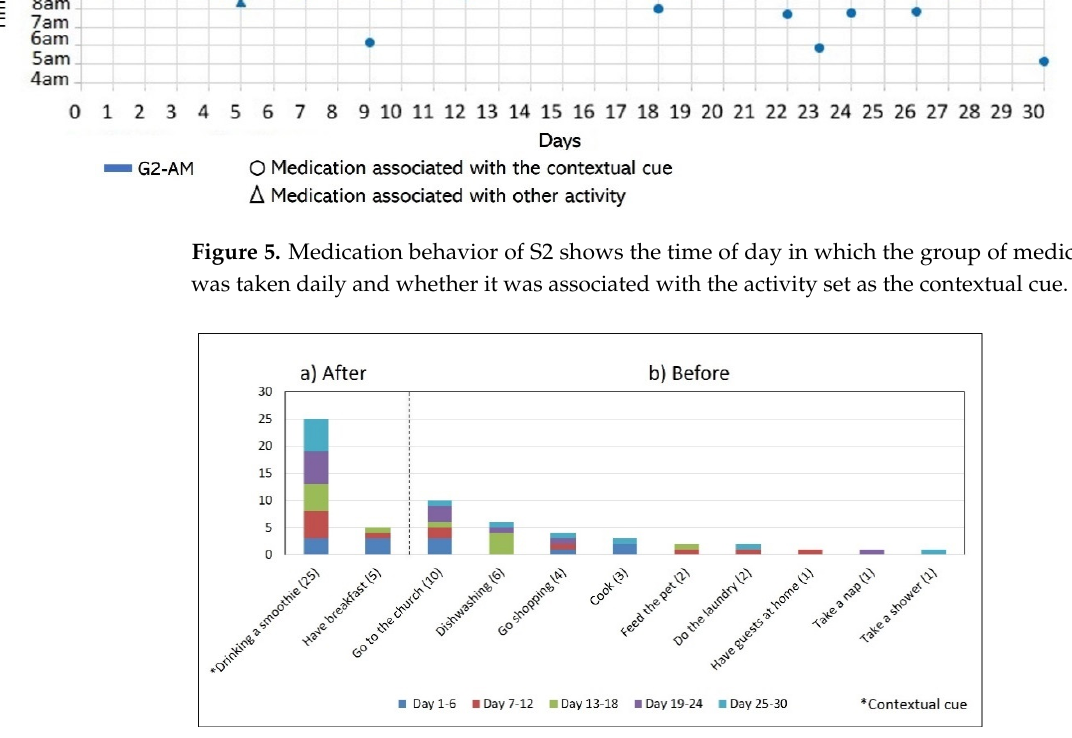
Figure 6. The number of days S2 performed the medication episode (G1-AM) after and before the reported activities.